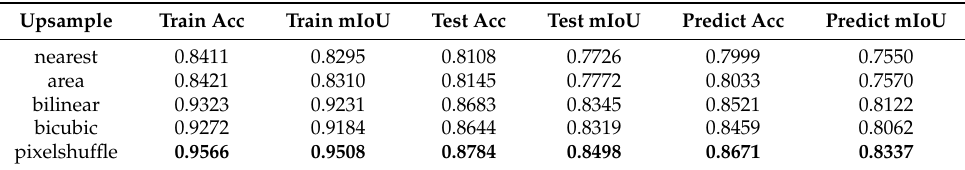
Table 3. The train accuracy, train mIoU, test accuracy, test mIoU, predict accuracy, and predict mIoU of the dataset from four kinds of spatial interpolation methods and pixelshuffle layer at the end of the network (the highest accuracy in each column is in bold format.